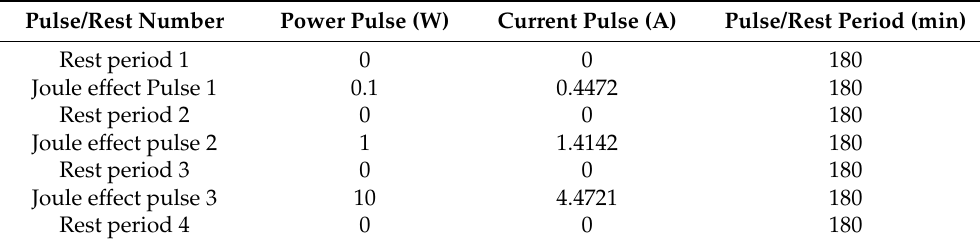
Table 1. Setup of the Joule effect protocol.